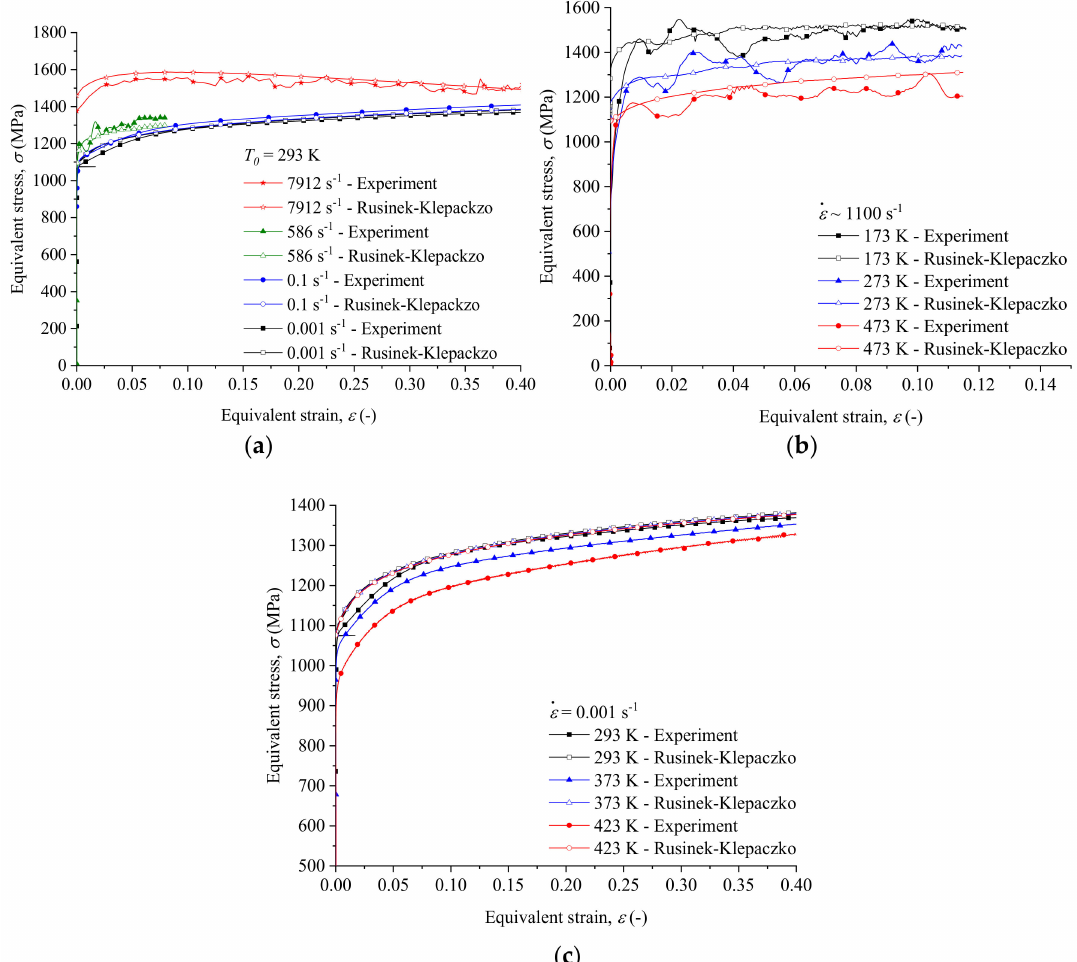
Figure 16. Comparison of the Rusinek–Klepaczko model and the experimental data: ( a ) for different strain rates, at T 0 =293 K; ( b ) for different temperatures, at ˙ ε ~1100 s − 1 and ( c ) for different temperatures, at ˙ ε = 0.001 s − 1